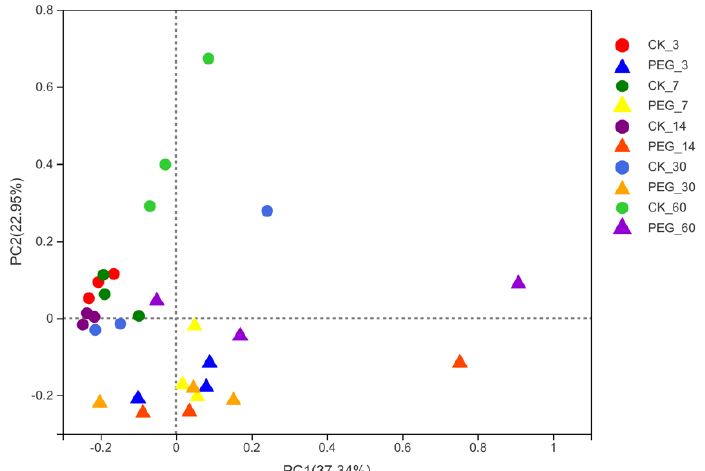
Figure 4. Principal − coordinate analysis (PCoA) plots based on weighted UniFrac distance for fungi community of treatments × days (CK_3: on day 3 of ensiling without addition of polyethylene glycol (PEG); PEG_3: on day 3 of ensiling addition of PEG, same as others) observed a clear distinction (R = 0.3305, p < 0.05) between fungi communities in control and PEG-treated silages during the entire ensiling day. These indicate that condensed tannins inhibit fungi activity; however, this effect might quickly disappear with prolonged ensiling.